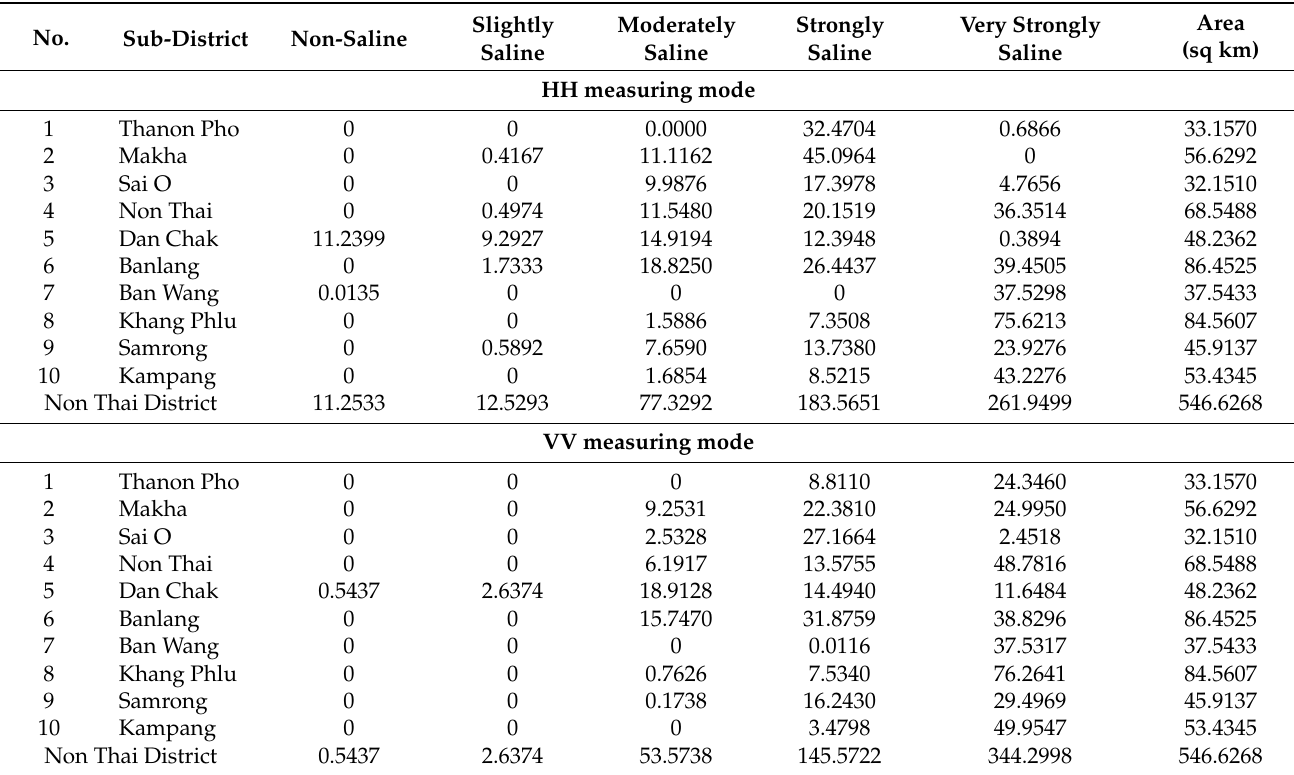
Table 18. Area of soil salinity severity classification with a suitable method in the two measuring modes by sub-district and